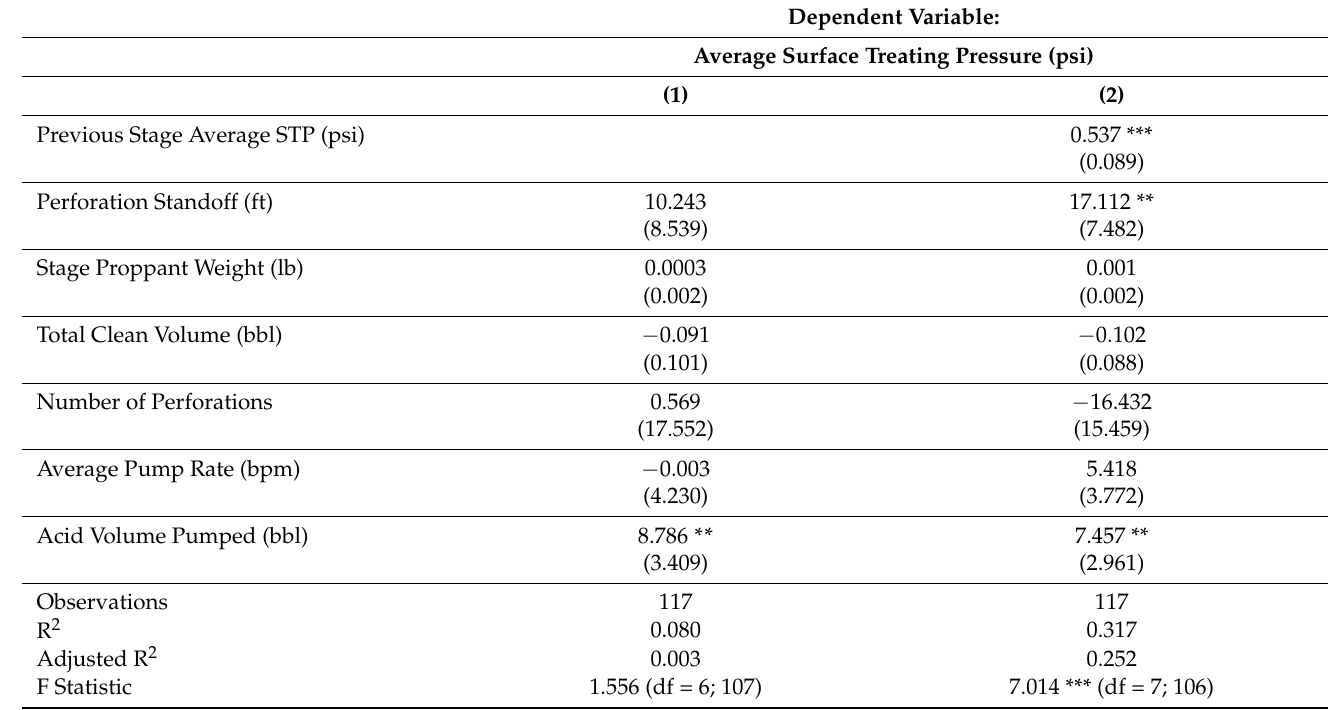
Table 3. Results from FE and dynamic FE models using the stargazer package from R [30].